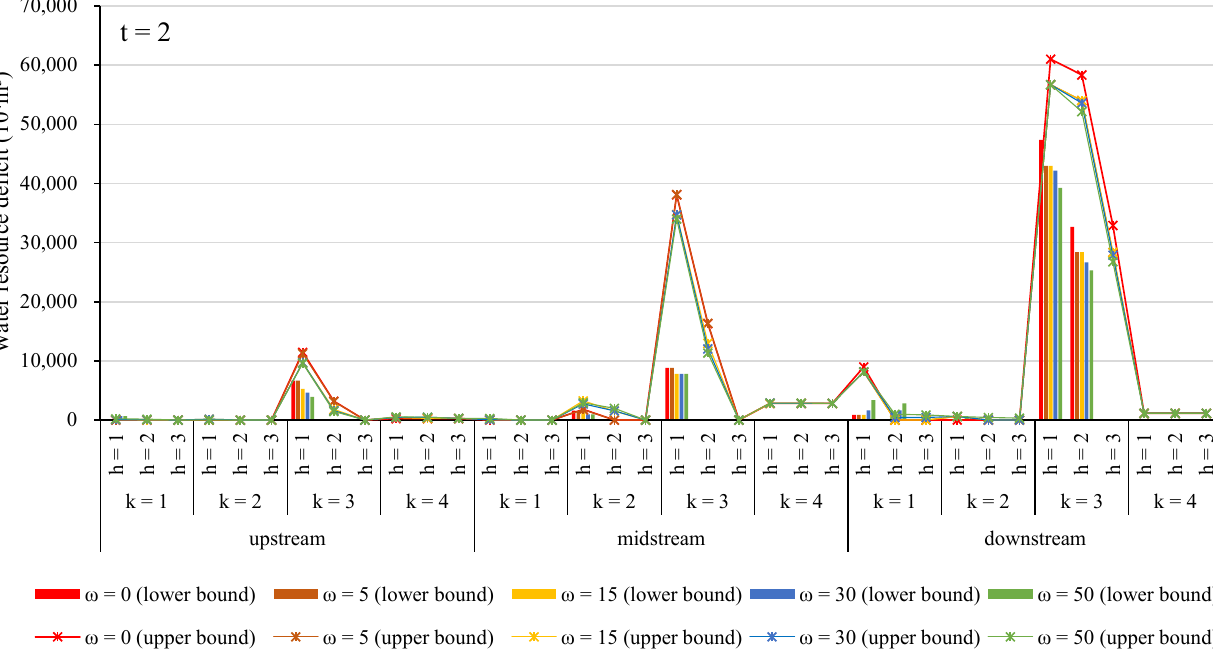
Figure 10. Water resource deficits by region in the Fenhe River Basin in period 3. Figures 11–13 show reused water resources by sector and region. Reused water re- sources are primarily allocated to industrial and domestic use, and the amounts increase with time. Reused water resources for the Fenhe River Basin in scenario 1 for ω values of 0, 15, and 30 were [12,084.09, 12,206.67], [11,920.16, 12,233.1], and [11,851.42, 12,169.68] × 10 4 m 3 in period 1; [18,120.25, 18,162.71], [17,600.76, 18,274.65], and [17,592.03, 18,274.65]